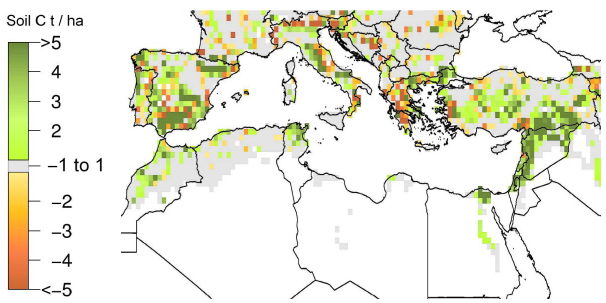
Figure 6. Difference between the HWSD soil carbon density and LPJmL-simulated soil carbon density before and after the model development presented here (/LPJmL Old − HWSD / − / LPJmL New − HWSD/). Positive values indicate an improvement in simulation of soil carbon stock due to the implementation of Mediterranean crops described in the present